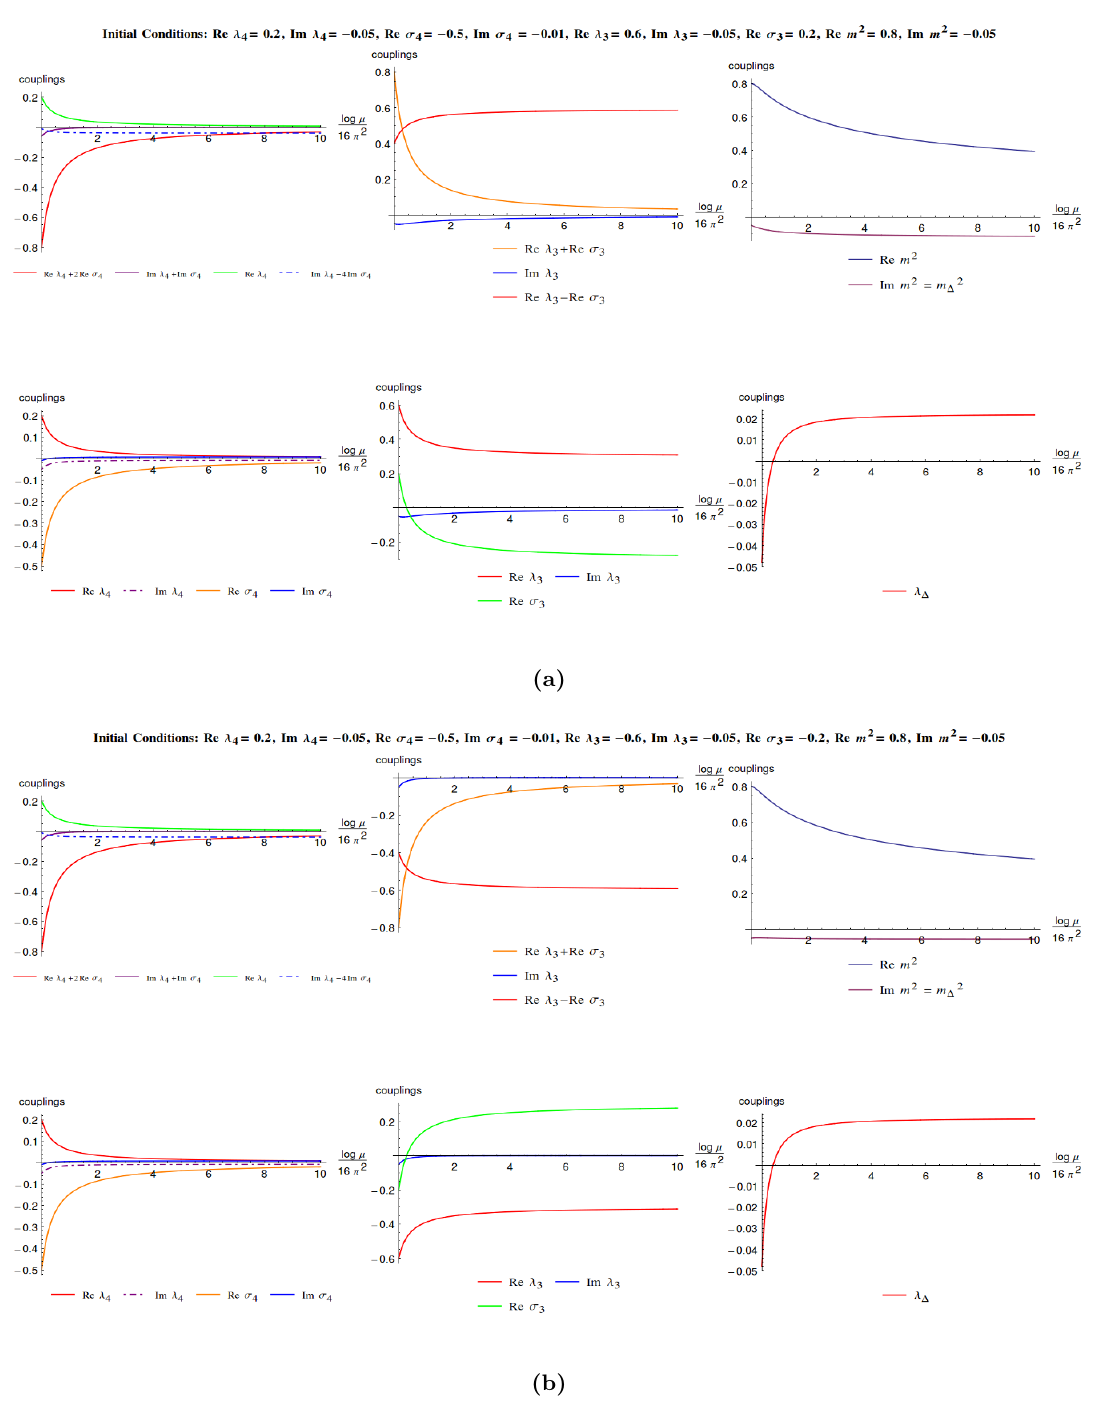
Figure 25. Figures showing the evolution of all the couplings for the case Re (cid:21) 4 + 2Re (cid:27) 4 < 0, Im (cid:21) 4 + Im (cid:27) 4 < 0 and the two sub-cases | Re (cid:21) 3 + Re (cid:27) 3 > 0 ((cid:12)gure a) and Re (cid:21) 3 + Re (cid:27) 3 < 0 ((cid:12)gure b).